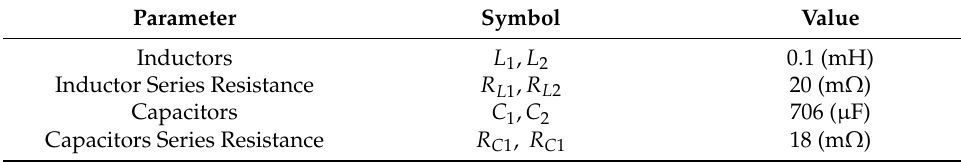
Table 4. Bidirectional quasi-Z-source inverter